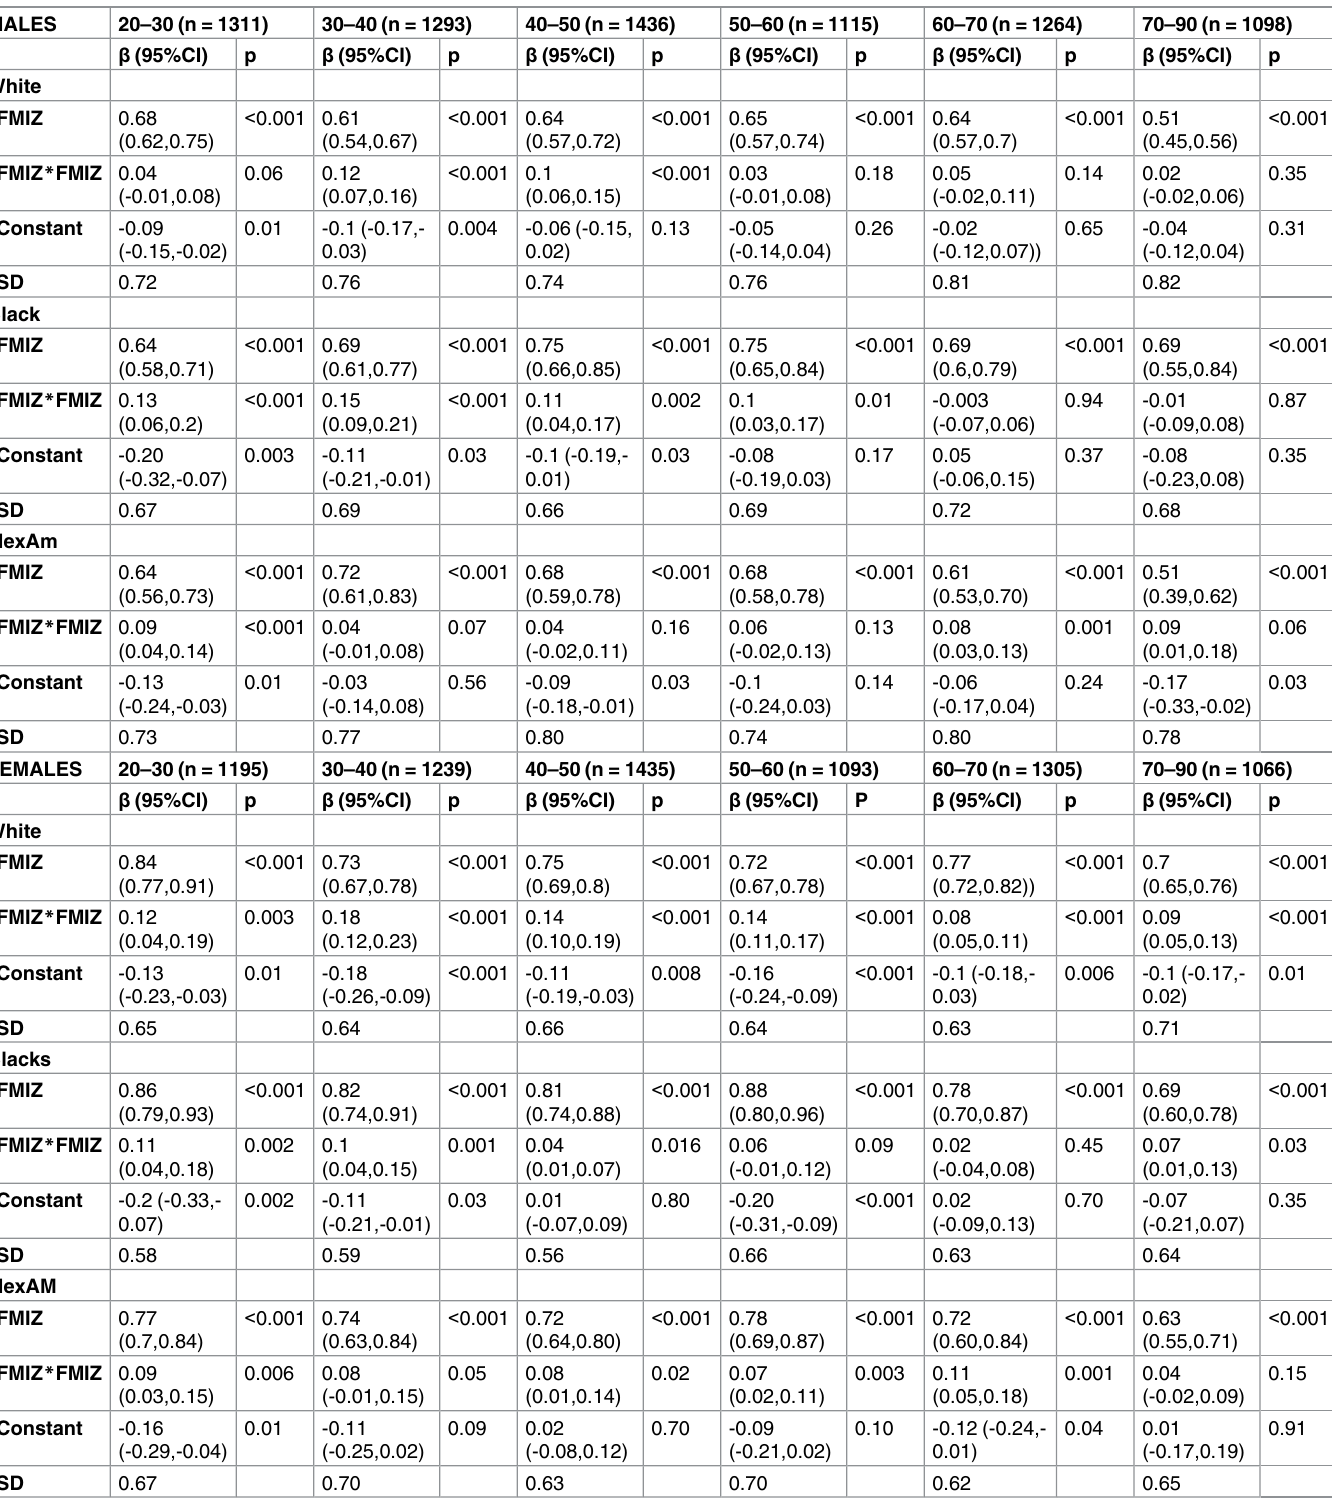
Table 1. Regressions of FMI on ALMI Z-Score within age, sex, and race categories.